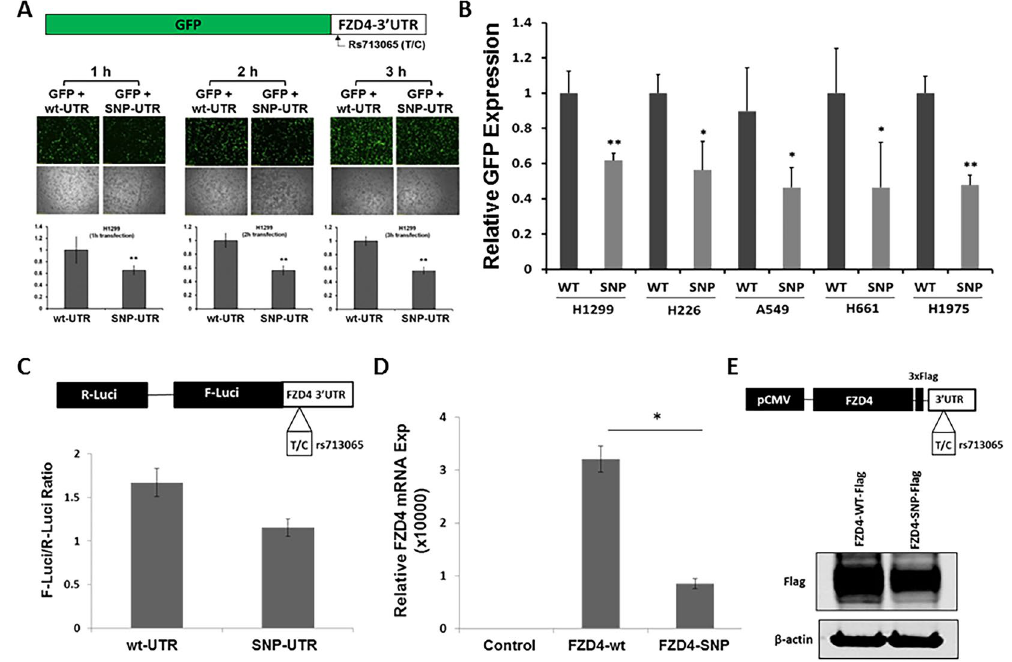
Figure 1. Effects of the variant allele rs713065(C) on FZD4 mRNA and protein expression. (A ) The C allele significantly down-regulates expression of a reporter consisting of the coding sequence of GFP and part of the 3 ′ UTR of FZD4 with variant (C) and wildtype (T) alleles at rs713065. Data are from six independent transfections. (B) Down-regulation of reporter gene expression by the rs713065(C) allele in H1299, H226, A549, H661, and H1975 cells. Data are from six independent transfections. (C) Dual luciferase reporter